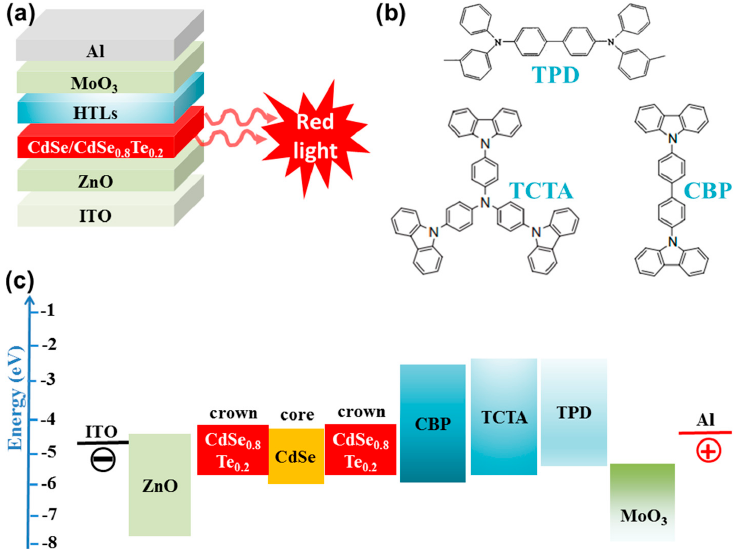
Figure 5. ( a ) The NPL-LED structures; ( b ) The molecular structures for hole transport materials; ( c ) The proposed energy levels for NPL-LEDs. Adapted from [37], with permission from © 2018